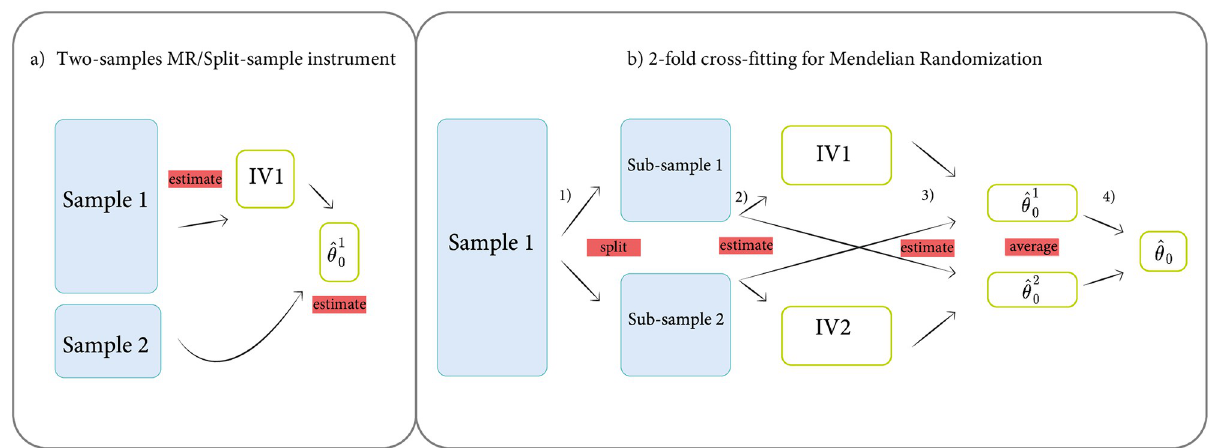
Fig 1. Schematic overview of two-sample MR and two-fold CFMR. Panel (a) shows the two-sample MR setup in which the first sample is used to build the instrument and the second sample is used to estimate the causal effect. Panel (b) shows the two-fold CFMR setup. Step 1 in panel (b) describes the random splitting of the dataset into two sub-samples. In step 2, two separate GWASs are performed: the first using sub-sample 1 and the exposure and the second using sub-sample 2 and the exposure. The predictors of the exposure are subsequently built based on sub-sample 1 (IV1) and sub- sample 2 (IV2). Step 3 refers to the 2SLS in which IV1 is applied to sub-sample 2 and IV2 is applied to sub-sample 1 to obtain the estimates of these IVRs. Finally, in step 4, the two 2SLS from step 3 are simply averaged to obtain the final